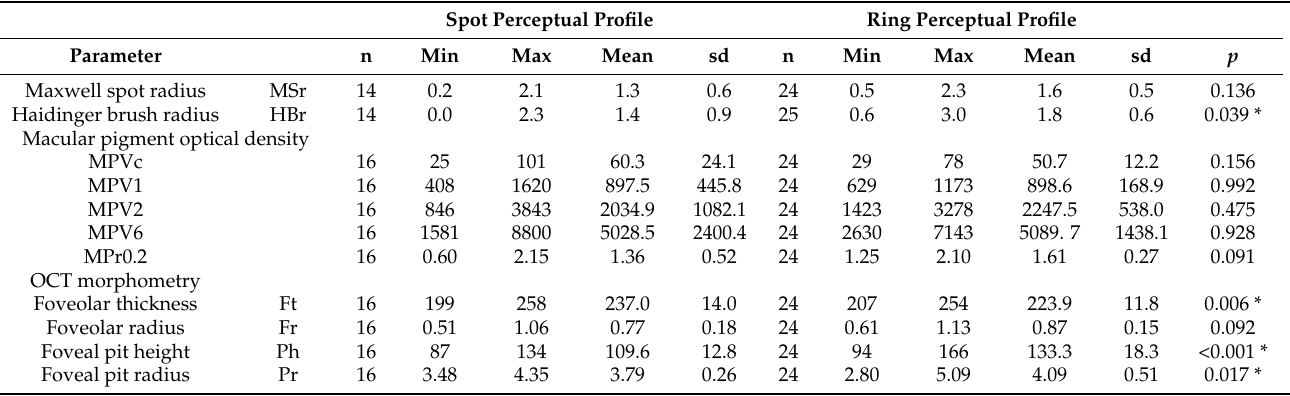
Table 3. Macular pigment and OCT results for MS classified into spot (category 1) and ring (categories 2 + 3) perceptual profile configurations. Final column ( p MS) shows results of a paired t-test comparing the spot/ring groups for each parameter. Other abbreviations as in Table 1.